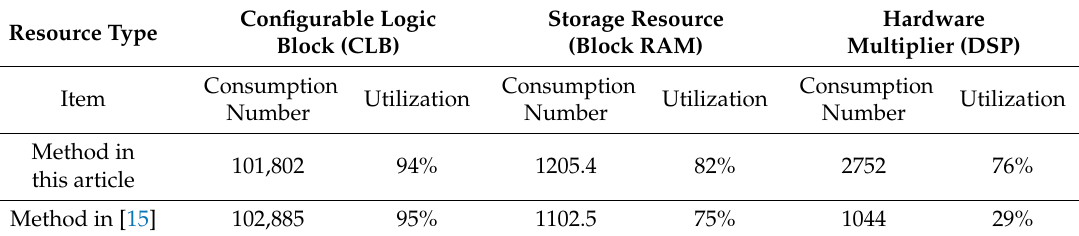
Table 1. FPGA resources utilized by two implementation